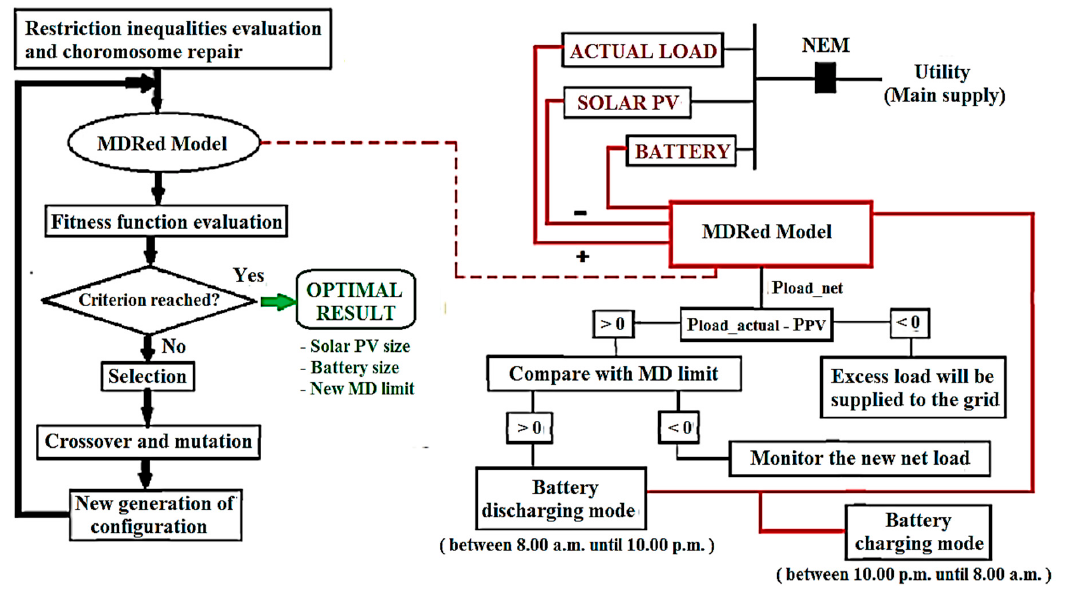
Figure 5. Flowchart of MDRed model for optimal sizing simulation using Genetic Algorithm. Table 7. Battery Energy management system for MDRed modeling approach.